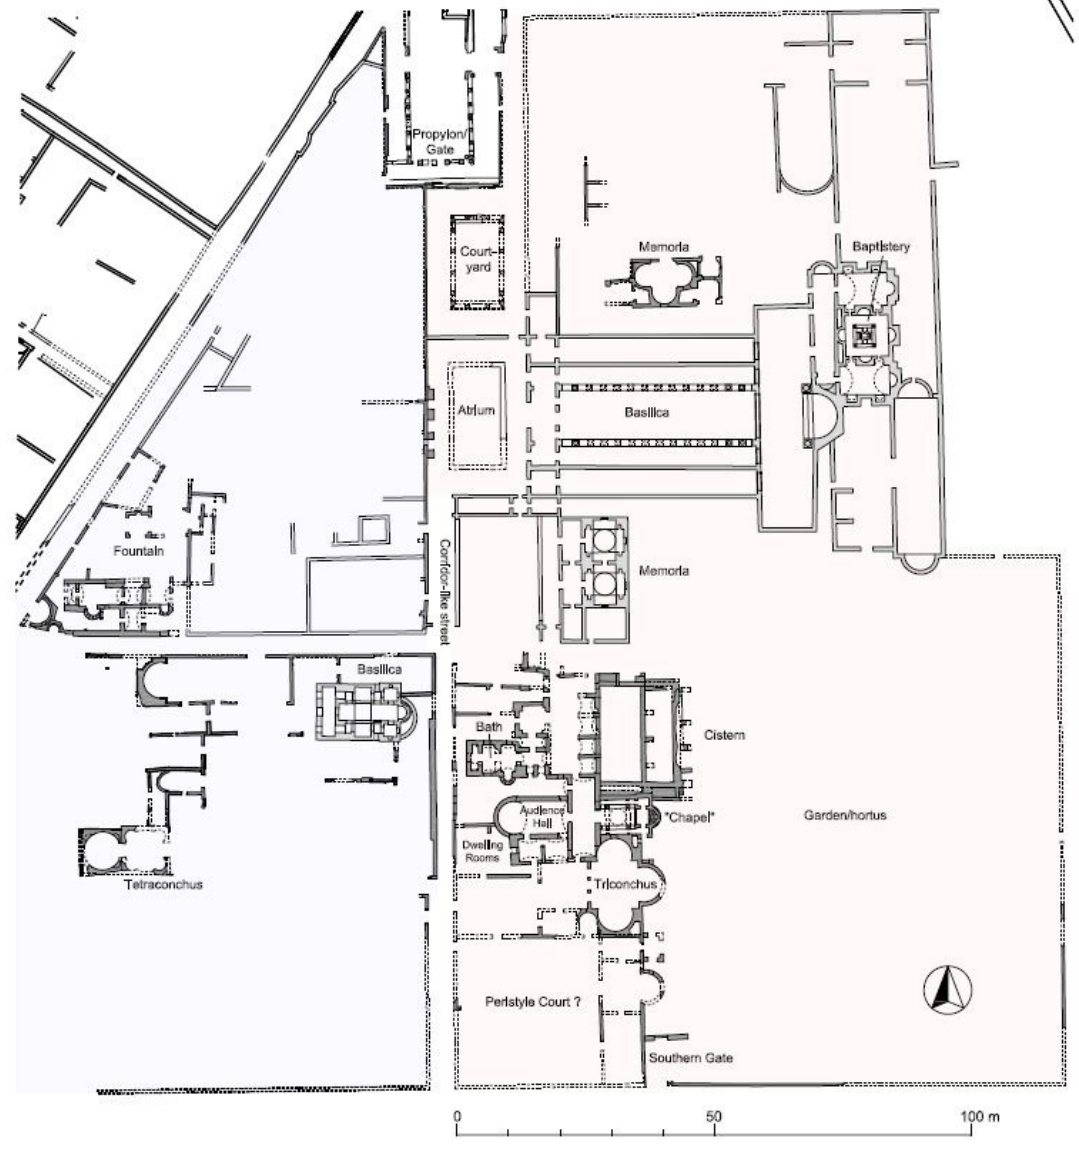
Figure 1. City map, detail with the episcopal district © ÖAW/IKAnt and Excavation